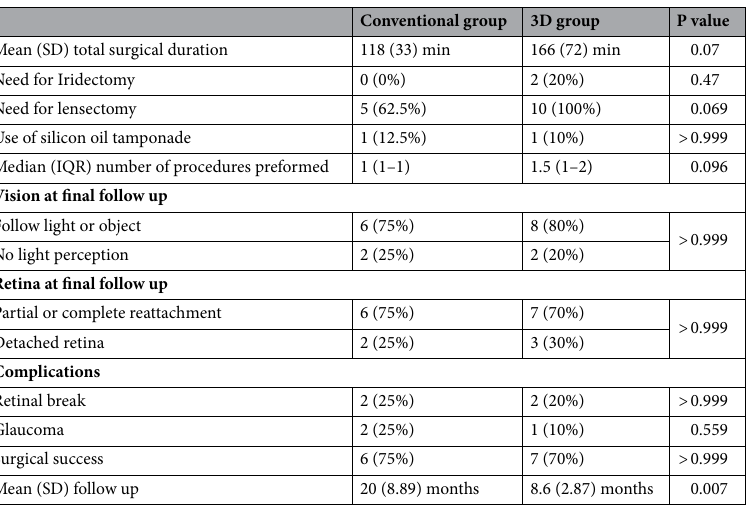
Table 2. Operative and postoperative characteristics comparison between both groups. SD standard deviation, IQR interquartile